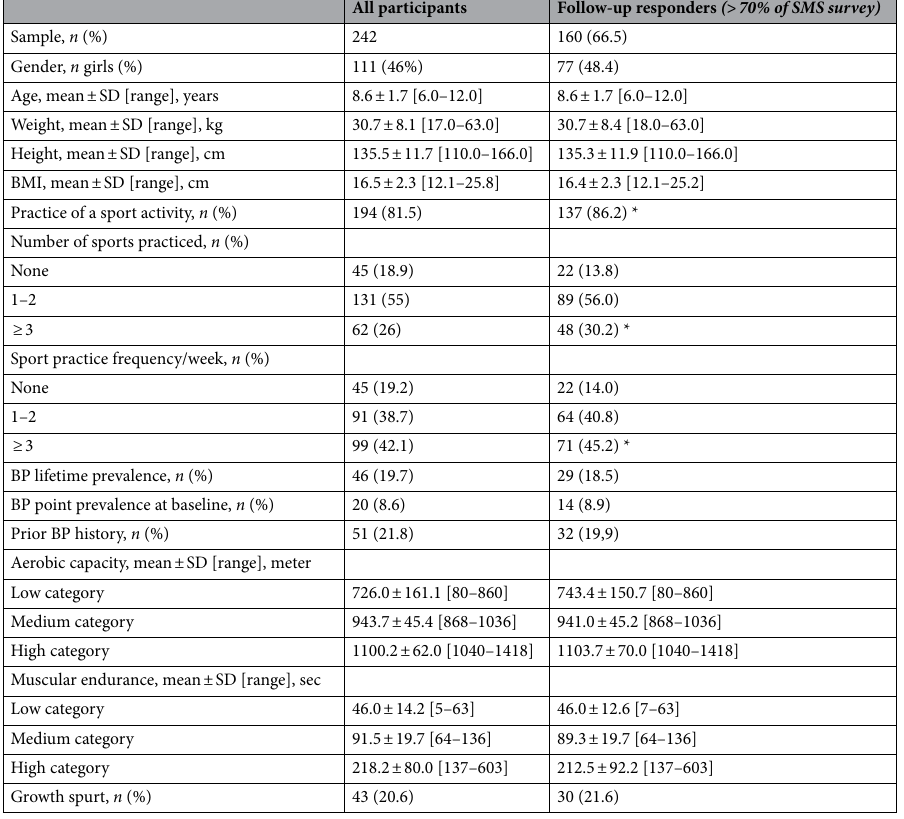
Table 1. Baseline characteristics of included participants and participants who responded to at least 70% of the SMS survey. * Significant difference ( p < 0.05) between study participants and responders with over 70% of SMS survey data over the course of the